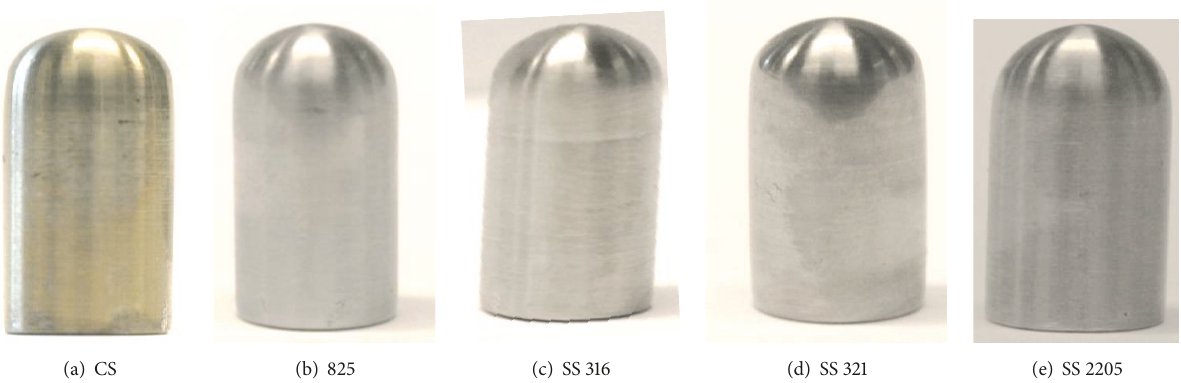
Figure 4: Cleaned alloy specimens after testing in stagnant 3.5% ABS at 60 ∘ C.